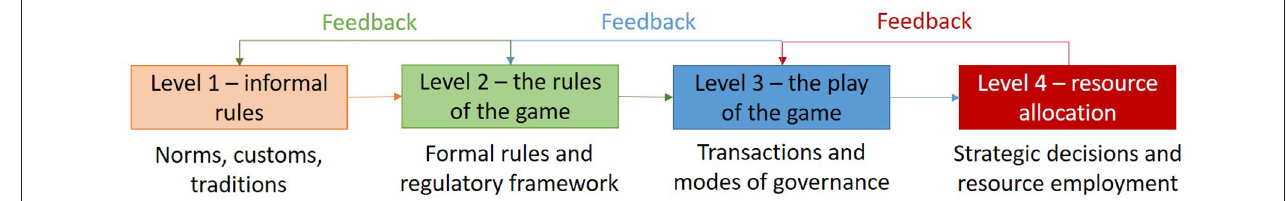
FIGURE 3 | Representation of the four levels of analysis of resource allocation in firms (Williamson, 2000).